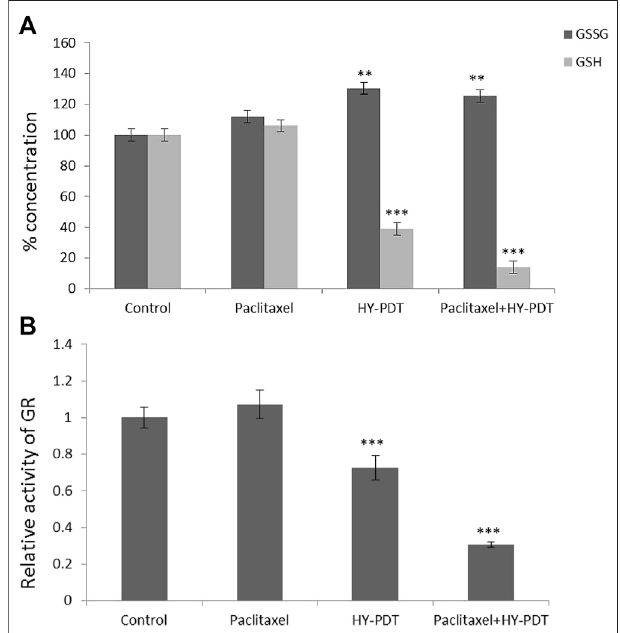
FIGURE 5 | Analysis of GSH/GSSG levels and relative activity of GR in B16-F10cells.Thecellsweretreatedwiththepaclitaxel(1 μ g/ml)andHY-PDT (1 μ g/ml) alone or in combination (0.5 μ g/ml each). (A) Intracellular concentration ofGSSG and GSH. ** p < 0.01, *** p < 0.001, compared to control. (B) Relative activity of GR. *** p < 0.001, compared to control.